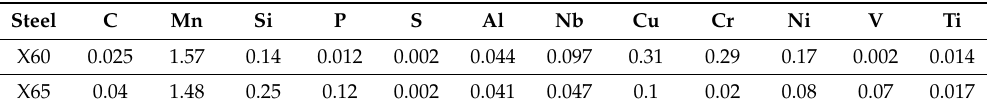
Table 1. Chemical composition of X-60 and X-65 micro-alloyed steels